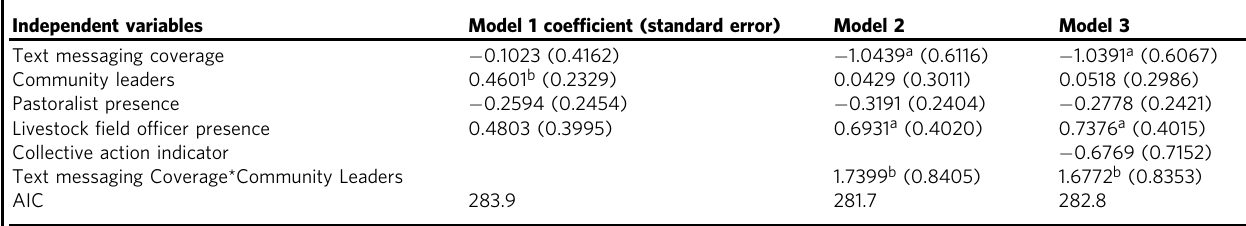
Numbers in brackets are the standard errors of the coef fi cients. Text messaging coverage is an indicator for the text messaging intervention, that takes a value between 0 and 1. If a village did not receive the text messaging intervention, its value is 0. If a village received the intervention, its value is equal to the number of phone numbers collected in that village divided by the estimated number of households in that village based on the district population size divided by the average household size. Presence of community leaders, pastoralists and livestock fi eld of fi cers are all binary variables, taking a value of one if the village received the intervention, if a pastoralist community resided in the village or if a livestock fi eld Of fi cer was permanently stationed in that village.The collective actionindicator takes values between 0 and 1 and was generated from a small experiment designed to capture the capability of a village to coordinate in collective action. A higher value indicates a greater ability to coordinate in collective action. For more information, see Methodology. Text Messaging Coverage*Community Leaders is an interaction term for the two advertising interventions. a Signi fi cant at 10% level. b Signi fi cant at 5%